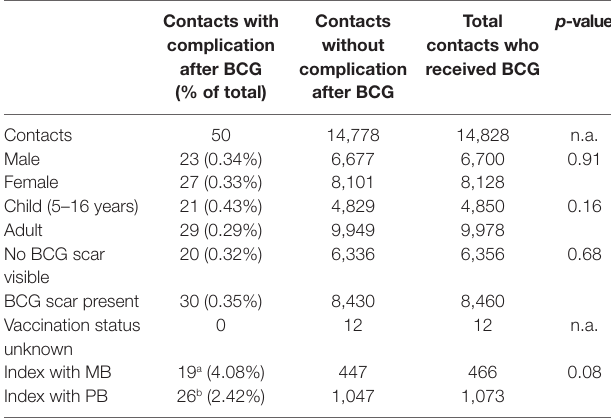
TaBlE 1 | Characteristics of contacts with or without complication after BCG